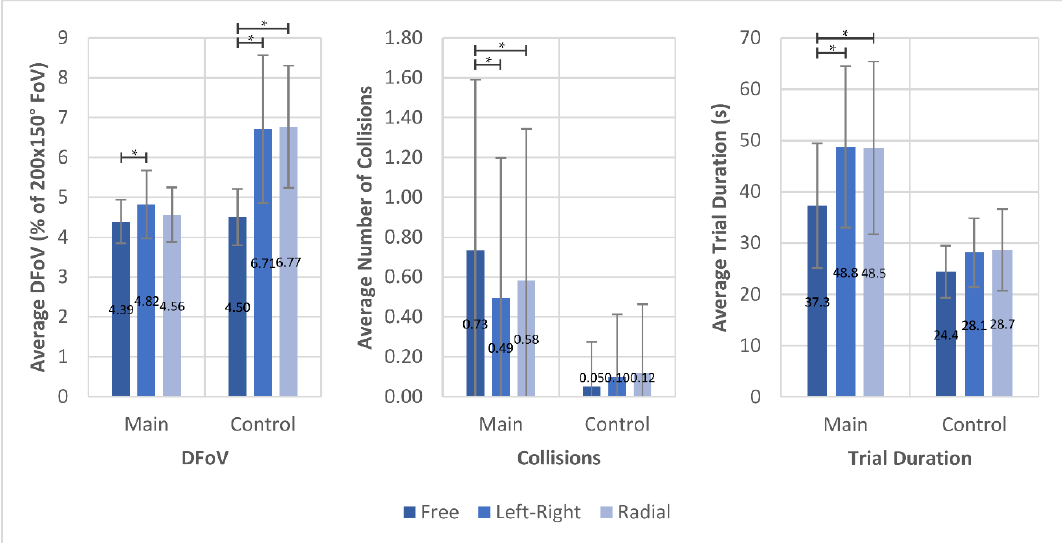
Figure 4. Comparison between average dynamic field of view (DFoV), number of collisions, and trial duration in the three different scanning pattern conditions during navigation for both main group and control group (* p < 0.05).